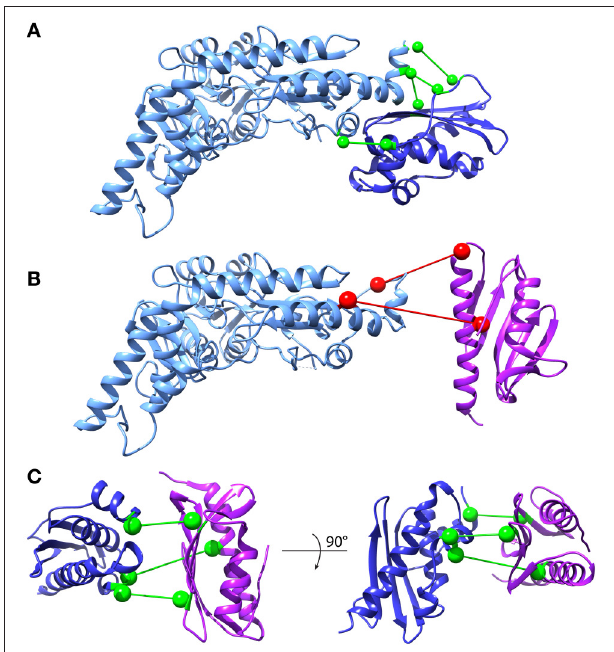
FIGURE 6 | Inter-protein contact predictions for CyaY/frataxin, IscU and IscS. Inter-protein contacts predicted by IPA are shown in a ball-and-stick representation. The spheres are centered on the C β atoms (C α for glycine). Light Blue: IscS, Dark Blue: IscU, Purple: CyaY/frataxin. Contacts are colored according to their estimated robustness, based on the IscU-IscS reference case (Green: Robust contacts, acceptance frequency > 85%; Red: Less robust contacts, acceptance frequency < 85%). (A) IscU-IscS interaction. The four contacts with highest acceptance frequency are shown. The IscU-IscS complex is drawn using the PDB 3LVL structure. (B) Frataxin-IscS interaction. No robust contacts are predicted for the frataxin-IscS case. The two contacts with the highest acceptance frequency (68%) are reported. (C) Frataxin-IscU interaction. Three contacts have a high acceptance frequency ( >